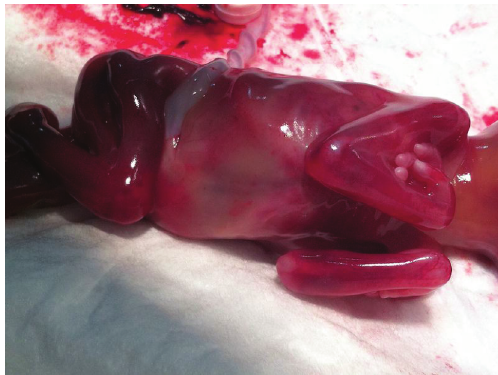
Figure 2: Photography of the fetus showing both legs and arms flexed and abnormally